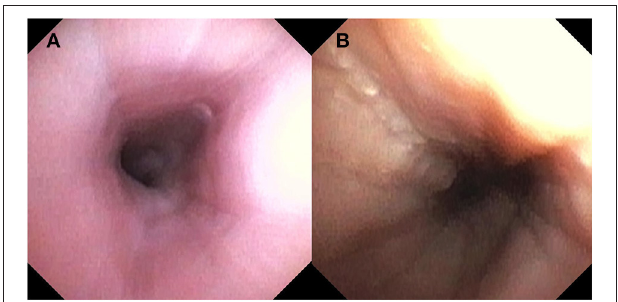
FIGURE 2 | Endoscopic findings with Transnasal Endoscopy including (A) normal esophageal mucosa and (B) longitudinal furrows and scant white